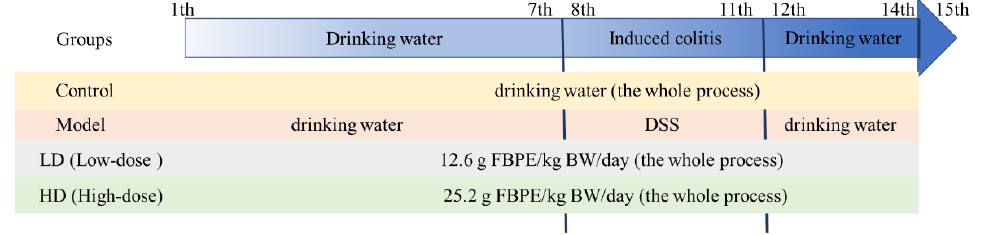
Figure 1. The experimental grouping and design.